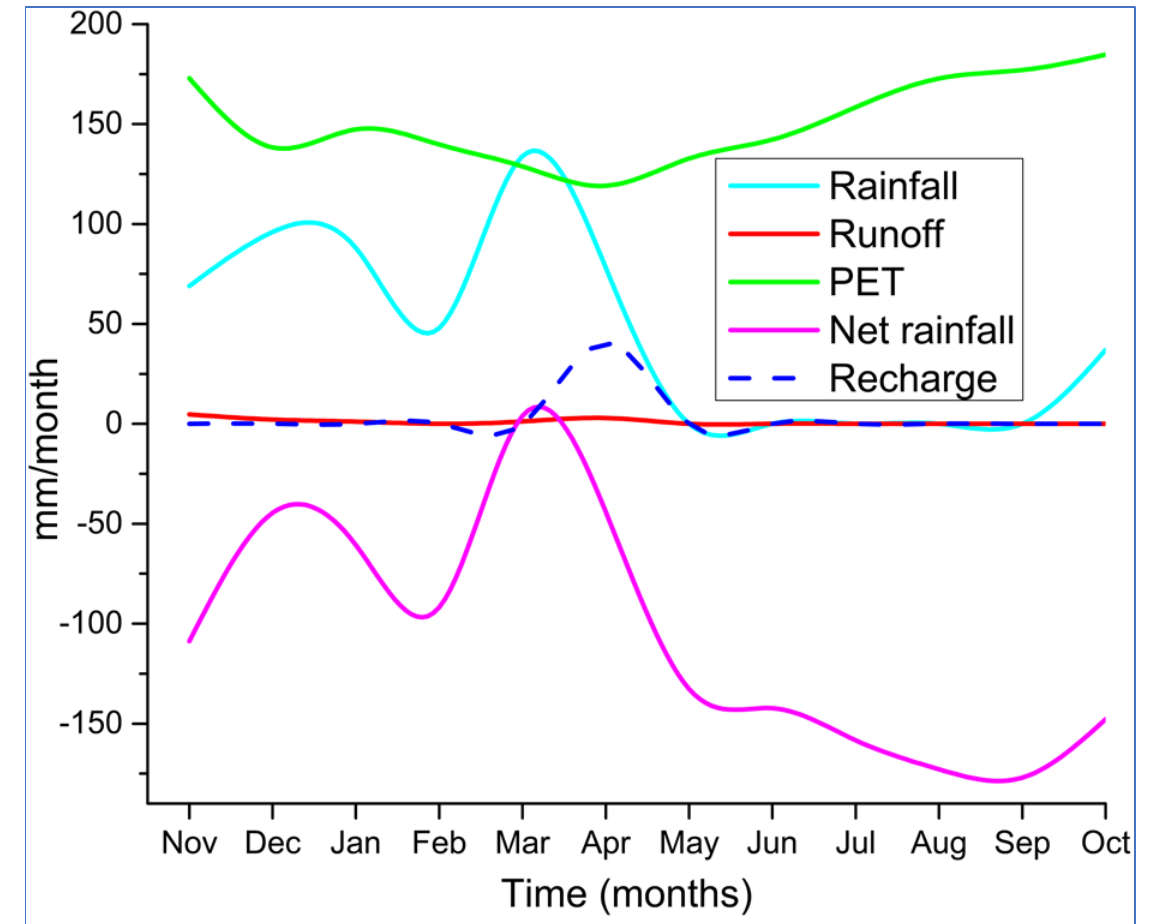
Figure 9. A 2005/2006 hydrological year graph of rainfall, runoff, PET, net rainfall, and aridity index in the Singida aquifer.